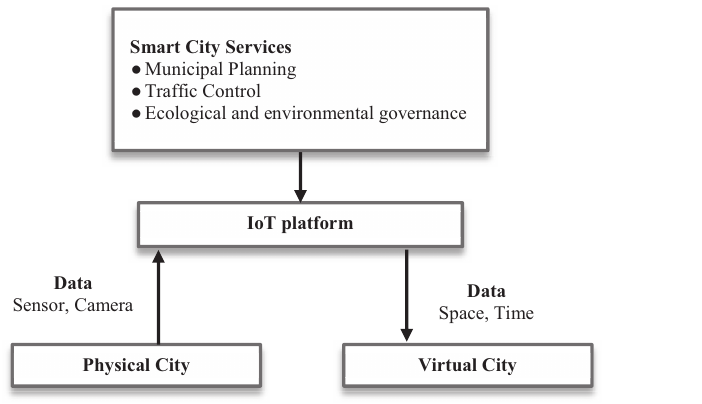
Figure 11. Smart city